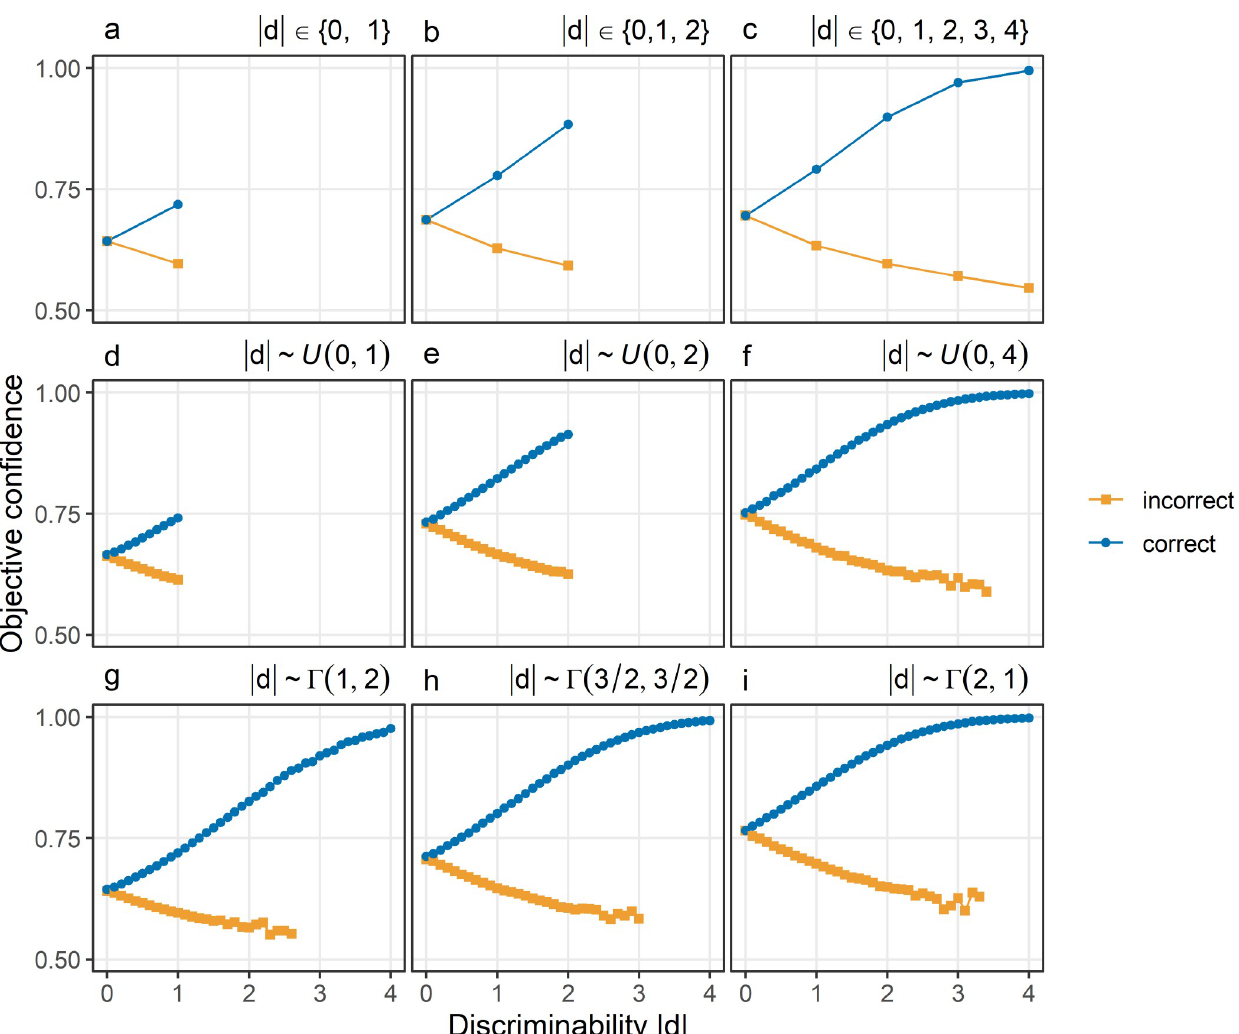
Fig 3. Objective confidence given the standard model of confidence. Confidence (y-axis) is shown as a function of discriminability (x-axis) in correct choices (blue) and incorrect choices (orange). Different panels show different distributions from which discriminability was sampled. Panels a-c: Discrete uniform distributions. Panels d-f: Continuous uniform distributions. Panels g-i: Gamma distributions. In all simulations, the percept e I was sampled from a normal distribution with a mean equal to the stimulus d and a standard deviation σ I of